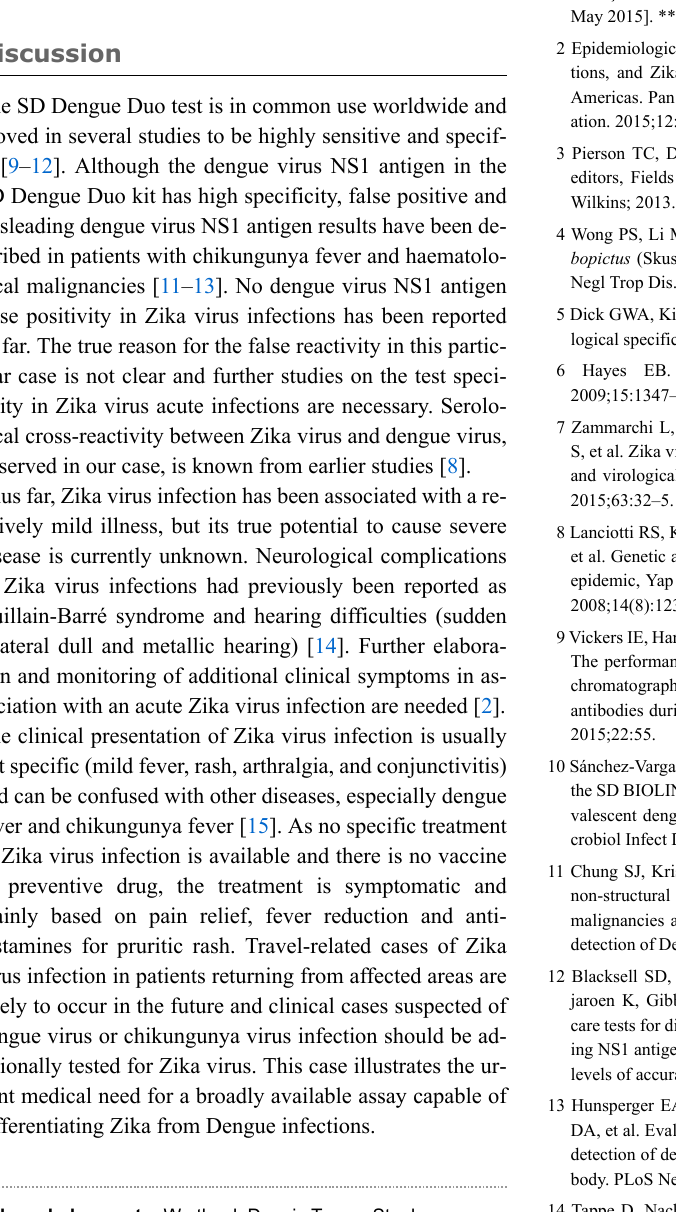
(table 1). This is underlined by the presence of Zika virus -specific neutralizing antibodies and the absence of dengue virus-specific neutralizing antibodies in the serum sample taken on July 1 (table 1). In the same serum, an IIFA for dengue virus demonstrated an IgG titre of 1:80, but neither IgM antibodies nor dengue virus RNA were detected in any serum sample (table 1). Further, in the serum of July 1 no IgG antibody titre increase to dengue virus was noted and the SD Bioline dengue virus NS1 antigen test became weakly